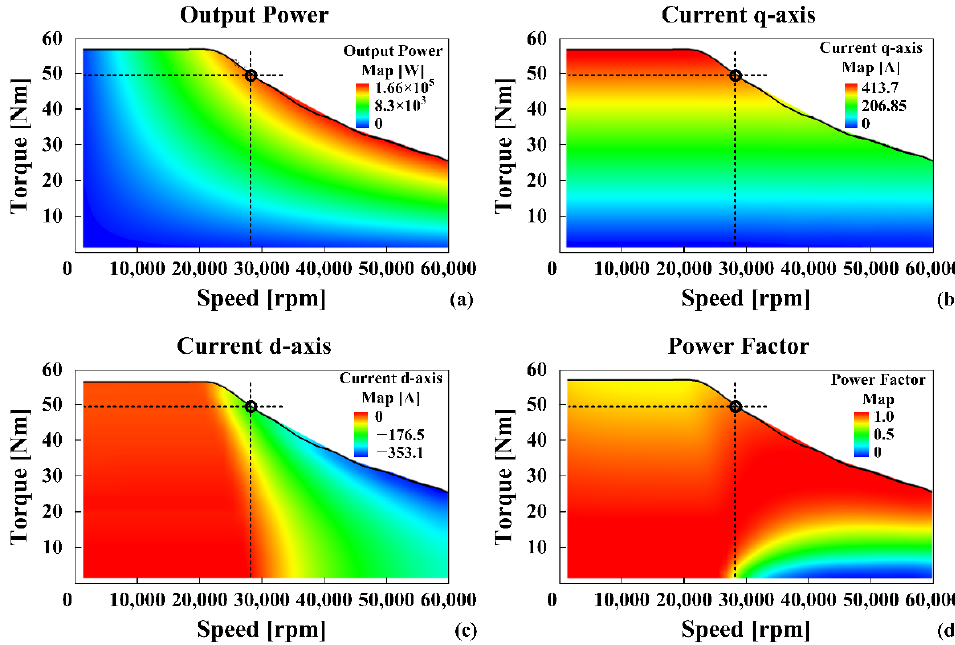
Figure 4. Operating performance results of SMC440 material shaft motor: ( a ) output power, ( b ) iq, ( c ) id, and ( d ) power factor.